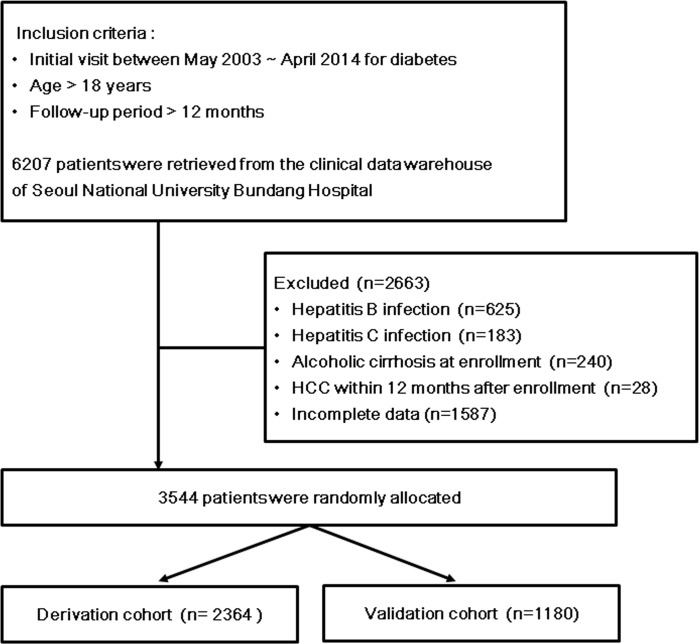
Study flow diagram.Diabetic patients without chronic viral hepatitis or alcoholic cirrhosis were identified and randomly allocated to derivation or validation cohort.